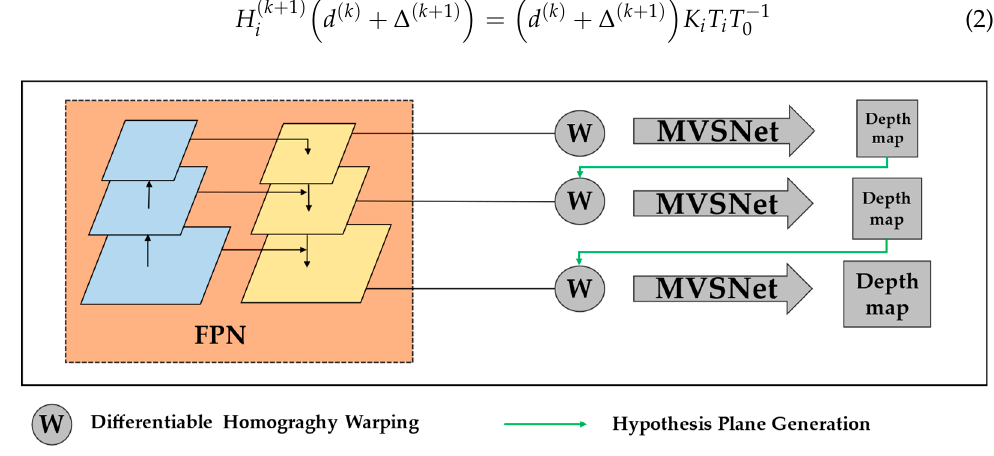
Figure 4. Coarse-to-fine computational deep MVS network.